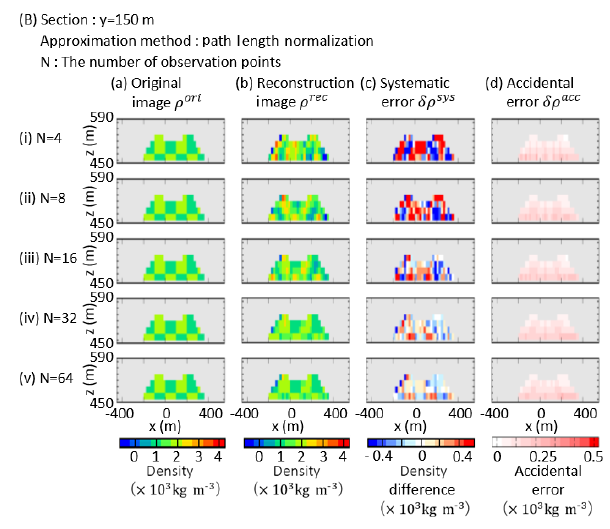
Figure 8. (B). Reconstruction of results on a y = 150m cross sec- tion.